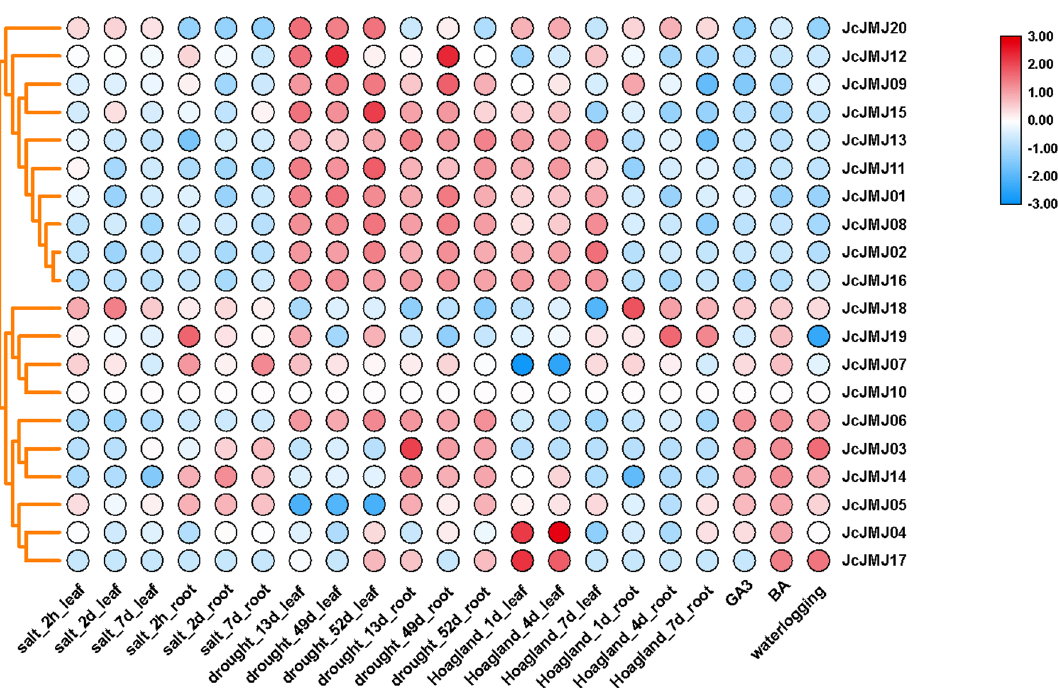
Figure 9. Expression patterns of JcJMJ genes under different treatments. Normalized log2 transformed values were used with hierarchical clustering represented by the color scale (− 3 to 3). Blue indicates low expression, and red indicates high expression. Cluster dendrograms by row scale are shown on the